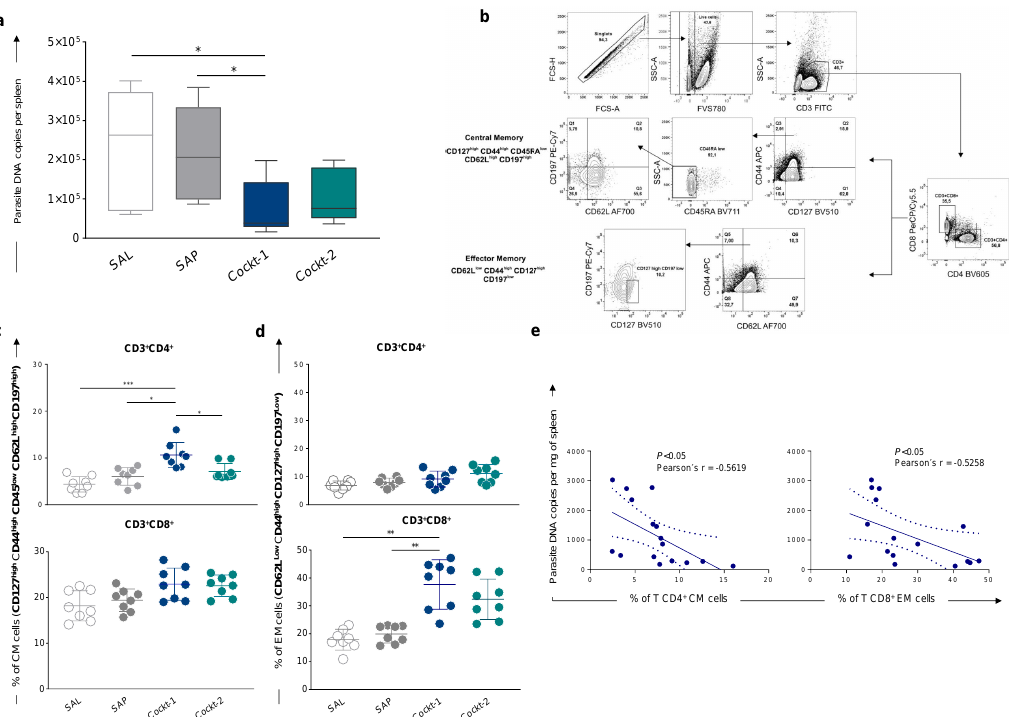
Figure 5. Parasite burden and memory correlation in spleens of immunized mice with a cocktail of peptide-based vaccine challenged with Leishmania infantum . BALB / c mice were immunized three times and challenged with L. infantum promastigotes, and then four weeks after, they were sacrificed for further analyses. ( a ) Parasite burdens were assessed in the spleen through quantitative PCR and results are expressed in parasite DNA copies per spleen. ( b ) Representative plot of gating strategy to evaluate central memory (CM) and e ff ector memory (EM) T-cells. CM cells were characterized by CD3 + CD4 + or CD8 + CD127 high CD44 high CD45RA low CD62L high C197 high markers, and EM cells were characterized by CD3 + CD4 + or CD8 + CD62L low CD44 high CD127 high C197 low after in vitro stimulation with SLA (soluble Leishmania antigen). Plots represent the frequency of CM T-cells ( c ) and EM T-cells ( d ) in mice splenocytes after in vitro stimulation with SLA. ( e ) Correlation analyses between parasite load and frequency of T CD4 + CM cells and T CD8 + EM cells are showed by Pearson’s r as means ± SD of two independent experiments ( n = 8), and p -values represent the di ff erence between the groups: * p- value < 0.05, ** p- value < 0.005, *** p- value < 0.0005. After that, to characterize memory phenotypes of T-cells, we investigated central (CM) and e ff ector memory (EM) cells in the splenocytes culture using an extensive panel of superficial markers. CM T-cell phenotypes were characterized by CD127 high CD44 high CD45 low CD62L high CD197 high